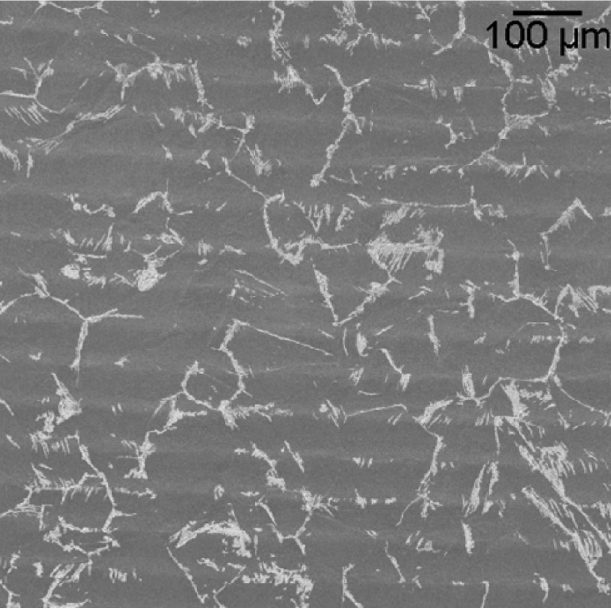
FIG. 2. CuAg5 pulse heating sample, T ¼ 110 (cid:5) C (courtesy of Lisa Laurent,